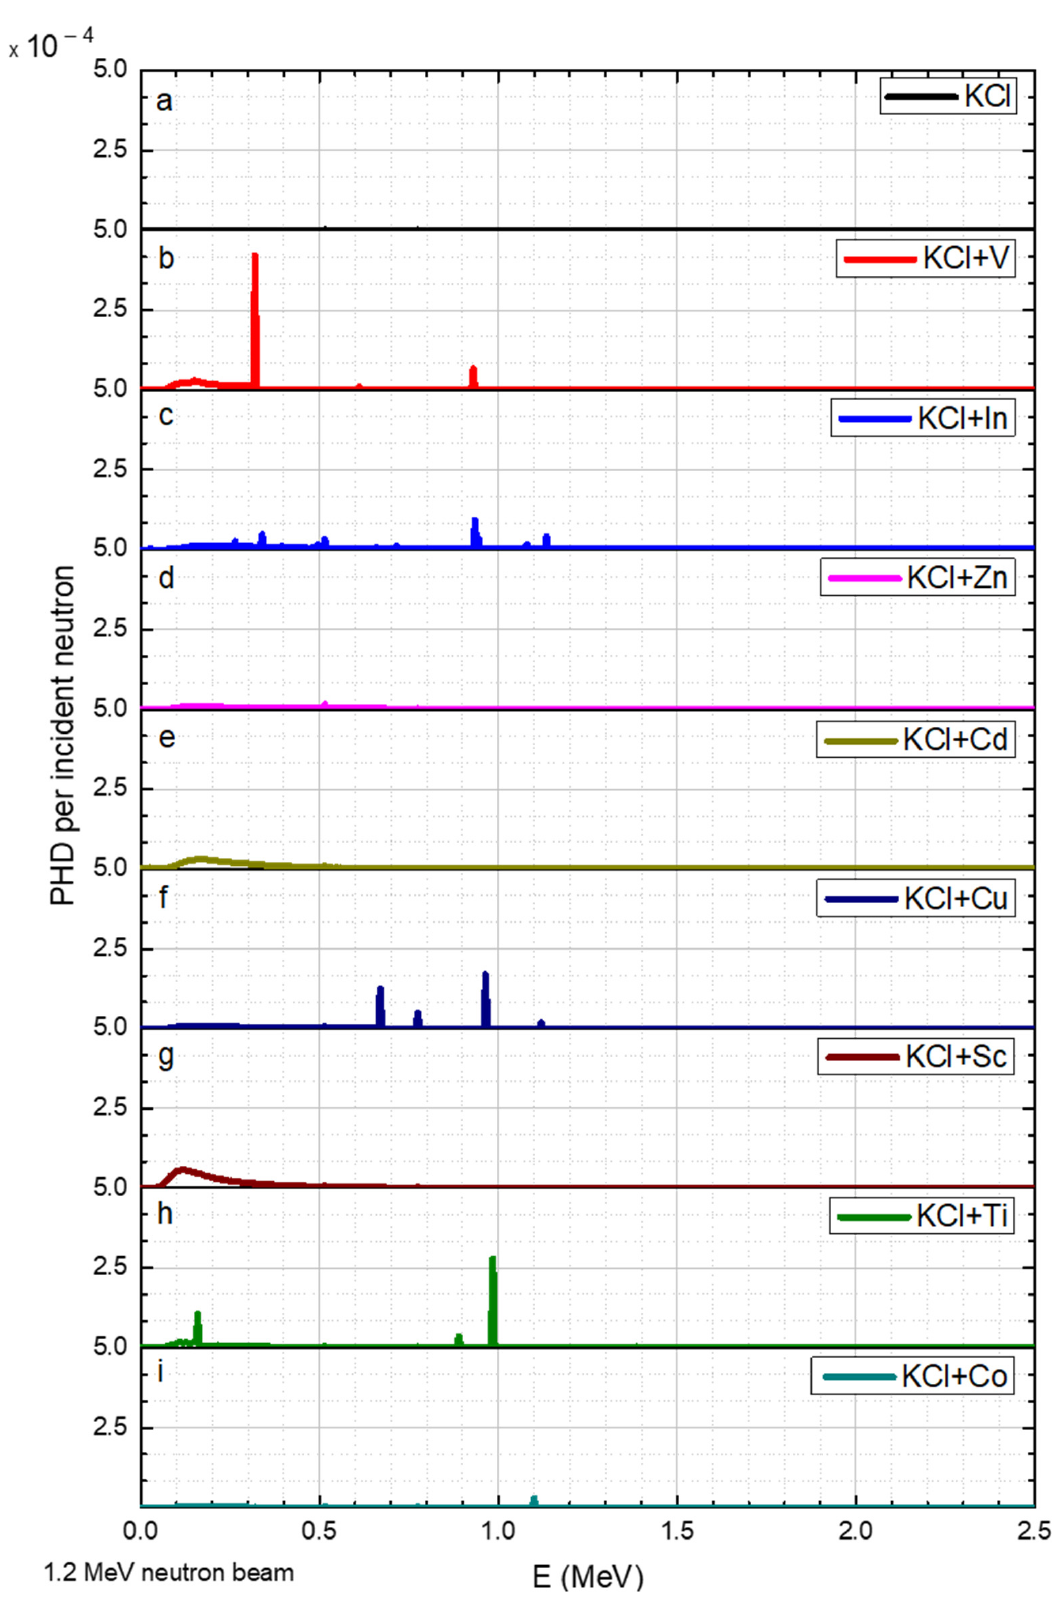
Figure 6. 1.2 MeV neutron energy of the PGNA results, where the y axis is the gamma pulse height distribution (PHD) per incident neutron obtained in the detector and the x axis is the gamma radiation energy. The data corresponds to a range of elements ( a – i ) added to the KCl.